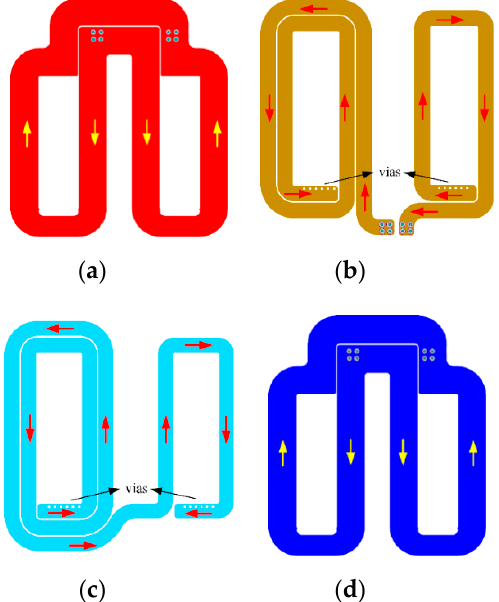
Figure 10. Winding arrangement for transformer T 1 . ( a ) Layer 1. ( b ) Layer 2. ( c ) Layer 3. ( d ) Layer 4.